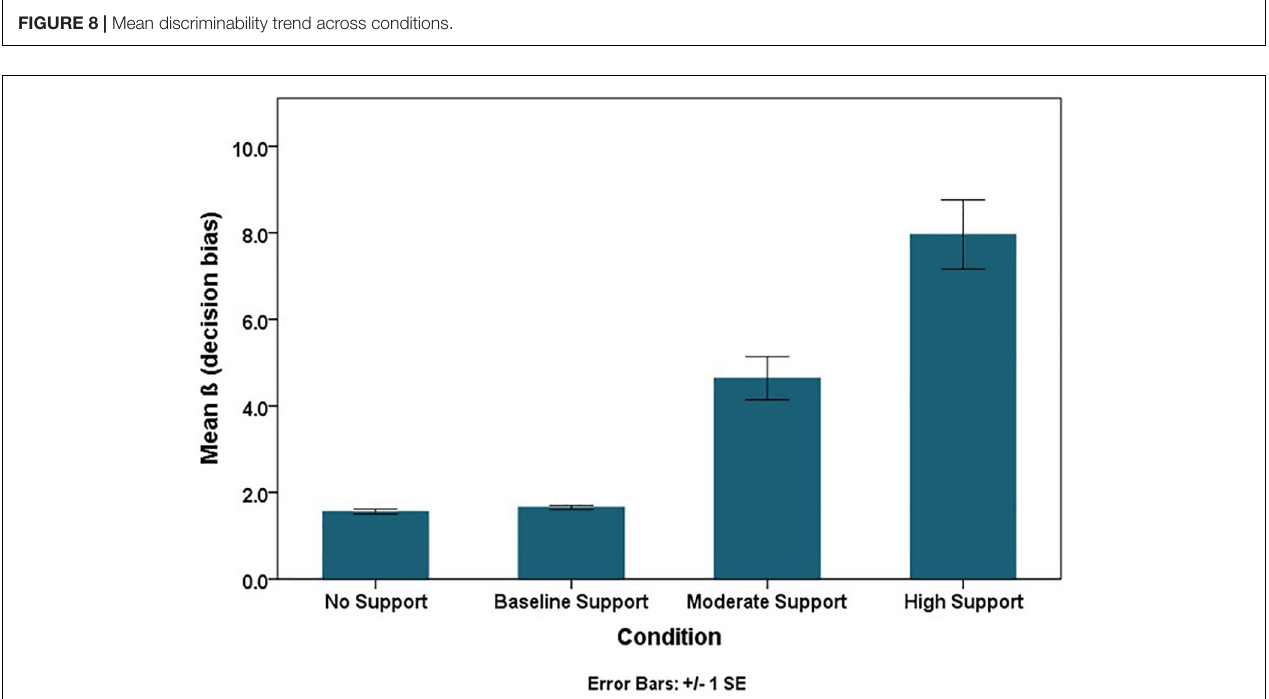
FIGURE 9 | Mean bias trend across